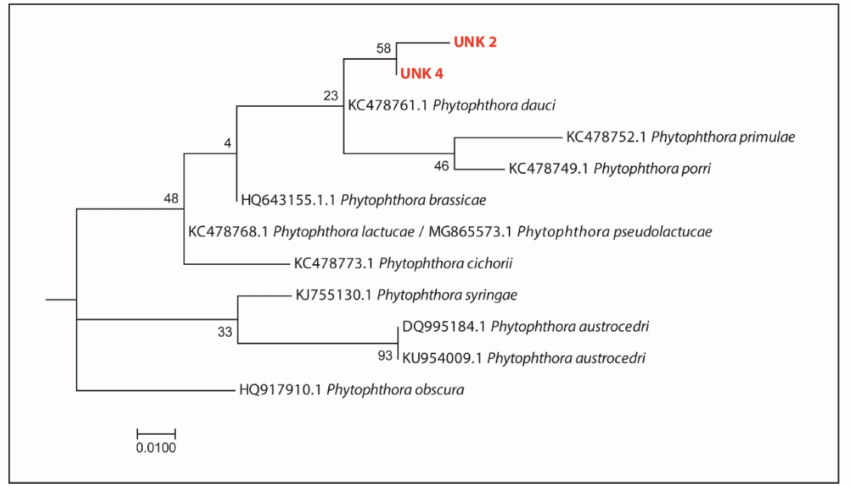
Figure 5. Sections from the phylogenetic tree of the Phytophthora ITS1 locus generated by the Maximum Likelihood method, based on the Tamura–Nei model. Position of Phytophthora unknown sp.2 and sp.4 within Phytophthora clade 8b. The bootstrap consensus tree inferred from 1000 replicates is taken to represent the evolutionary history of the taxa analyzed. Branches corresponding to partitions reproduced in less than 50% bootstrap replicates are collapsed. The percentage of replicate trees in which the associated taxa clustered together in the bootstrap test (1000 replicates) is shown next to the branches.